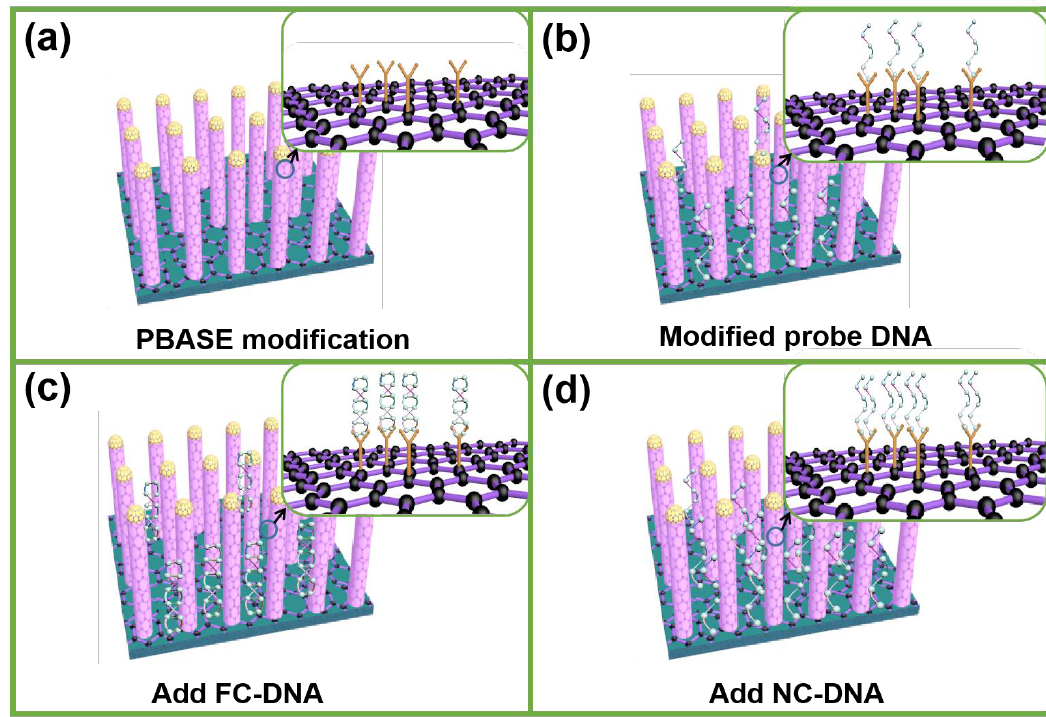
Figure 8. ( a ) The schematic diagram of PBASE modified on the metamaterial surface. ( b ) Schematic diagram shows the process of modifying probe DNA. ( c ) Schematic diagram after adding complementary DNA to the super material LSPR sensor. ( d ) Schematic diagram of adding unmatched DNA to the metamaterial LSPR sensor, with the enlarged details in the upper right corner.